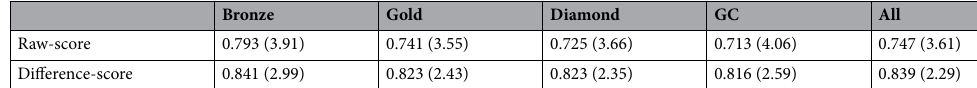
Table 1. R 2 (mean of squared residuals) of the Random Forest models created using the raw and difference- score metrics for each ranks and for all ranks